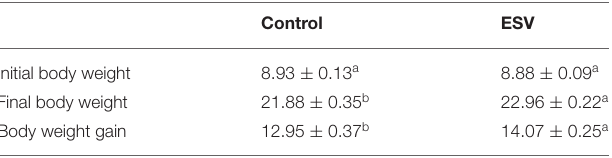
TABLE 5 | Evaluation of an experimental subunit vaccine (ESV) against enterotoxigenic E. coli (ETEC) on initial body weight, final body weight (day 57), and body weight gain of weanling piglets.